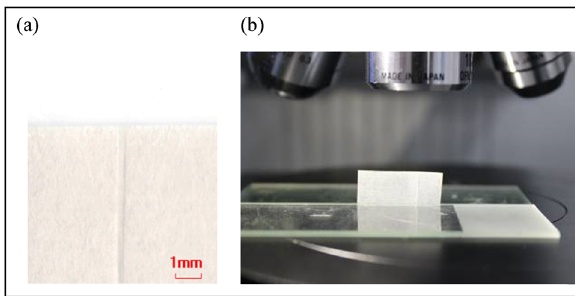
Figure 1: Yarn sample preparation. ( a ) Yarn stuck fl at on the double - sided adhesive tape and ( b ) double - sided adhesive tape clamped by two glass slides.